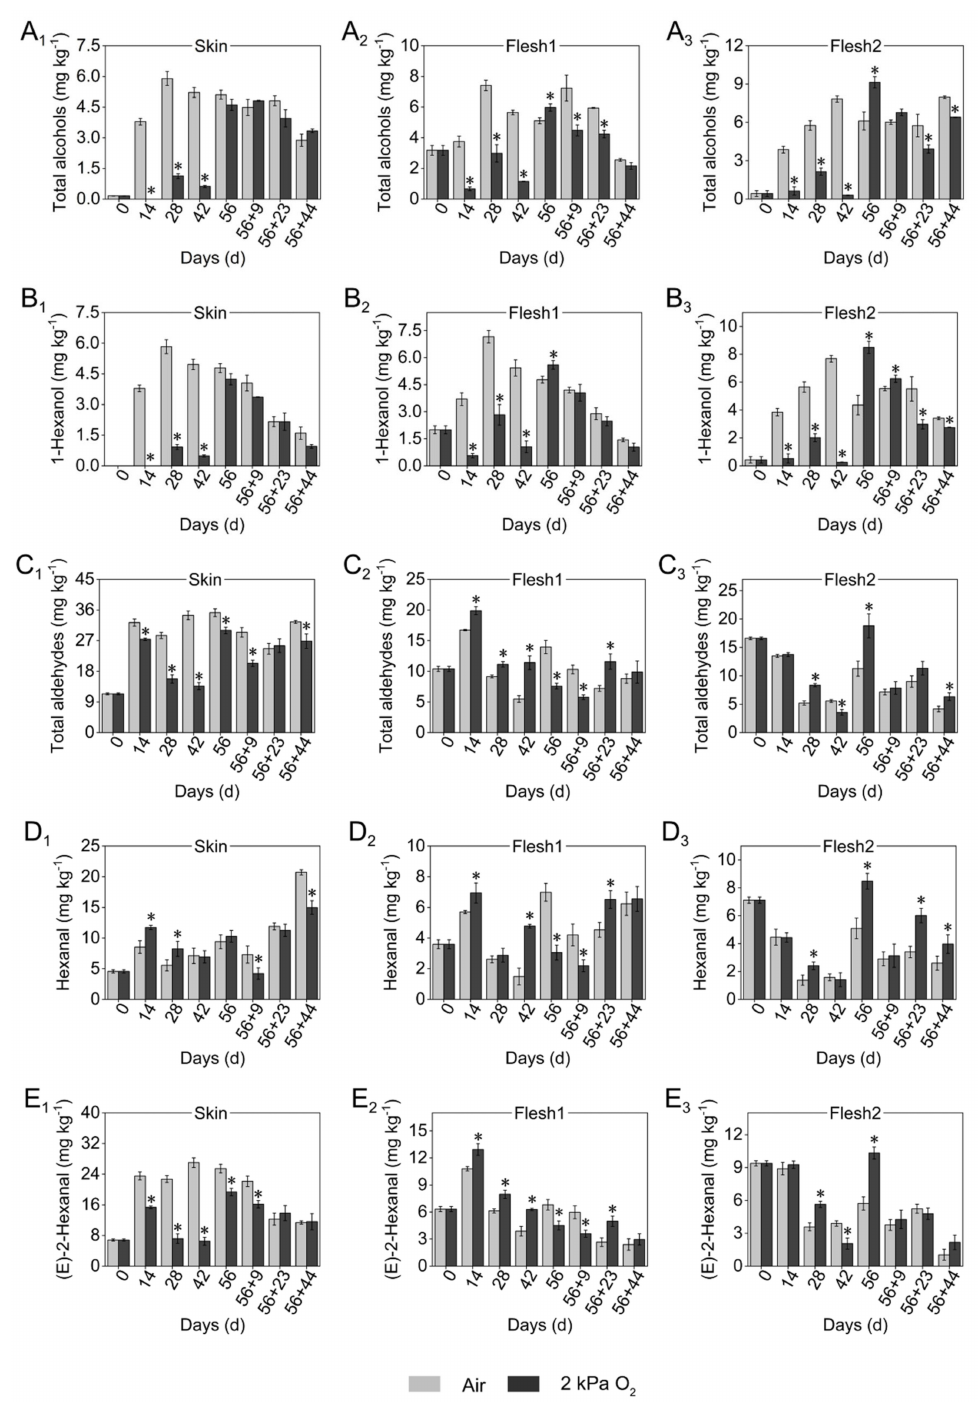
Figure 3. Key alcohol and aldehyde content in skin and flesh of ‘Golden Delicious’ apple fruit during 56-day storage under 2 kPa O 2 + 98 kPa N 2 at 4 ◦ C and subsequent 44-day shelf life at 20 ◦ C. The contents of total alcohols and 1-hexanol, are shown in ( A 1 – A 3 , B 1 – B 3 ), respectively. The contents of total aldehydes, hexanal and (E)-2-hexanal are shown in ( C 1 – C 3 , D 1 – D 3 and E 1 – E 3 ), respectively. Air represents apple fruit stored in air; 2 kPa O 2 represents fruit stored under 2 kPa O 2 + 98 kPa N 2 . Skin indicates tissue obtained, top 0 − 0.1 mm tissue of top pericarp; Flesh1 and Flesh2 indicate flesh tissues obtained, respectively, 0.1 − 1.0 cm and 2.0 − 3.0 cm below the exocarp. Bars indicate standard deviation for each mean value from at least three replicates. Asterisks indicate significant difference between air-stored and 2 kPa O 2 -stored fruit at p < 0.05 (Duncan’s multiple range